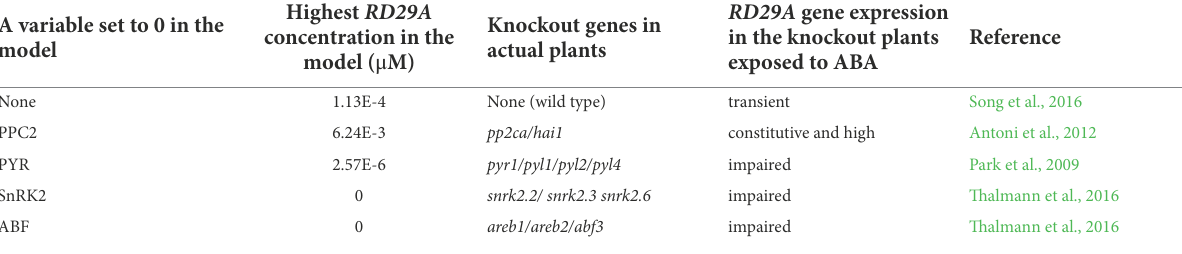
Mutant simulations were made on the model with the variable ABA set at 100 μ M. Highest concentration of the variable RD29A at each of the simulations was recorded. Relative expression of the RD29A gene in actual plants was curated from previously published